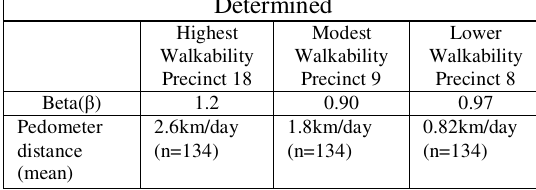
Table 10: Precinct 18, 9 And 8 Beta ( β ) Values